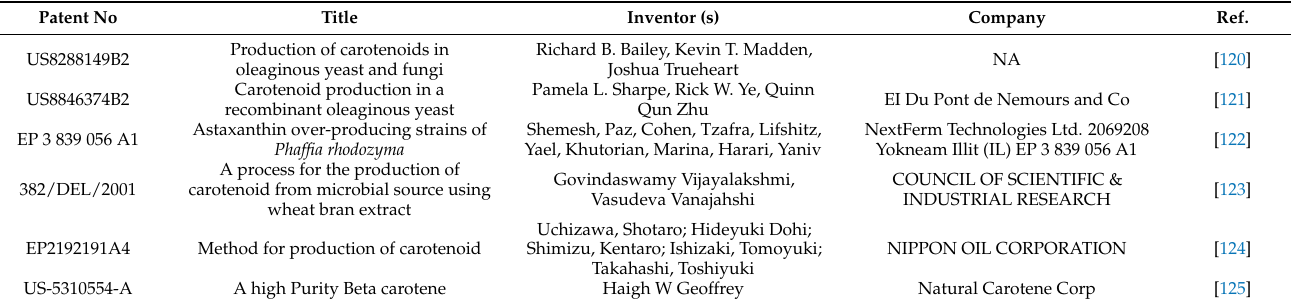
Table 2. Table showing the various types of patents filed for carotenoids reflecting their importance for industrial